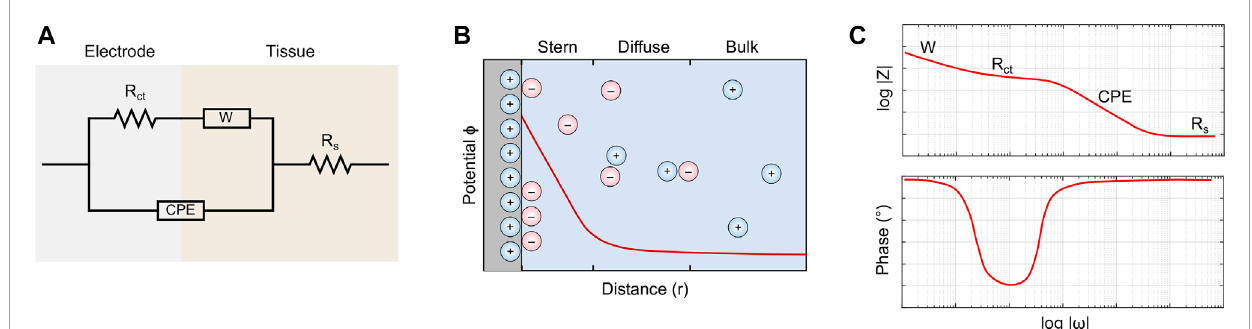
FIGURE 1 (A) The Randles equivalent circuit captures both Faradaic and non-Faradaic ionic interactions occurring at the electrode-tissue interface. (B) The interface is modeled as an electrochemical double layer. The Stern region consists of oppositely-charged ions that adhere to the electrode surface, while the diffuse layer consists of highly organized aggregates. (C) A bode plot showing the impedance of the equivalent circuit as a function of frequency. Impedances of high frequencies tend to the value of R s